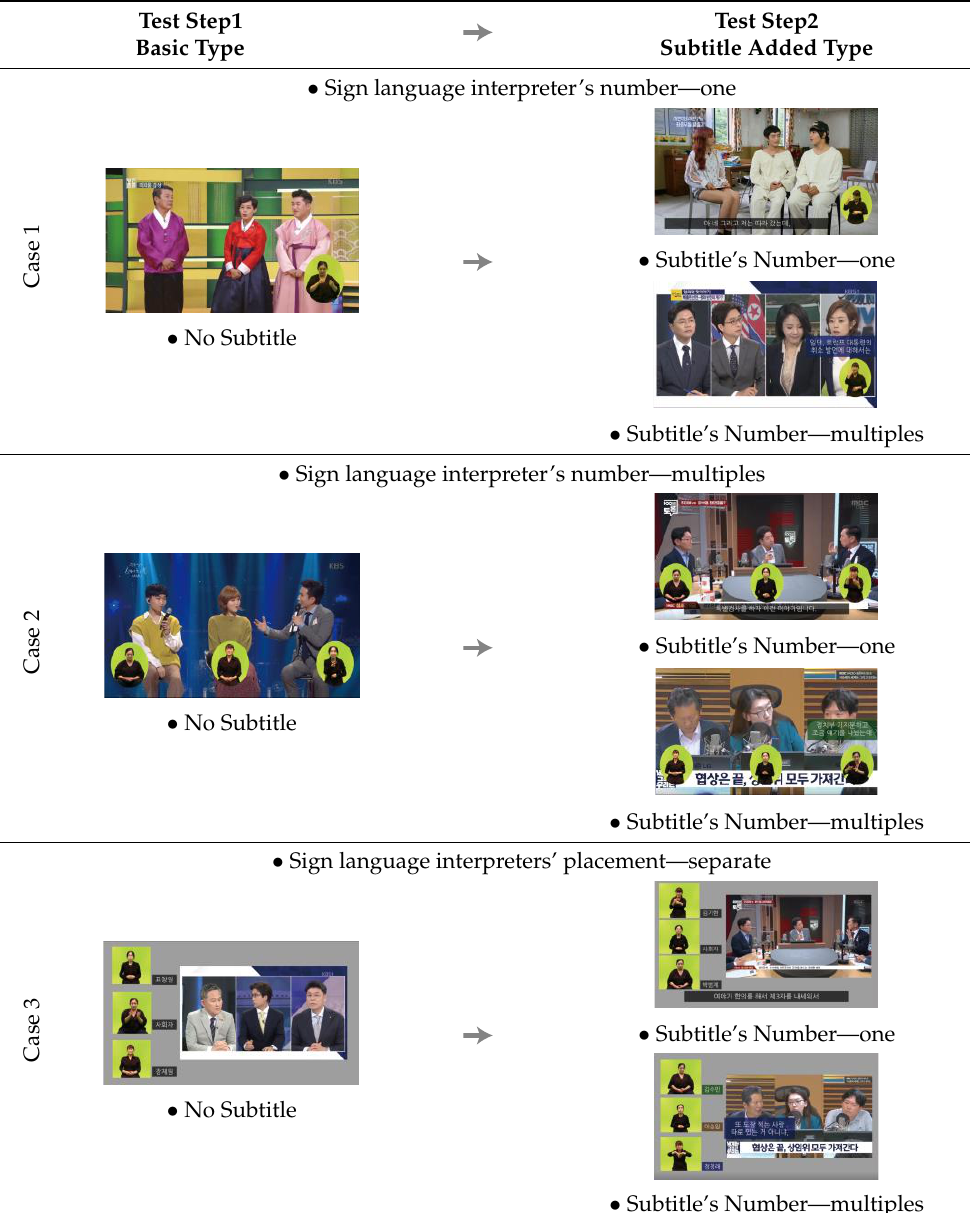
Table 3. Experiment design for panel discussions.